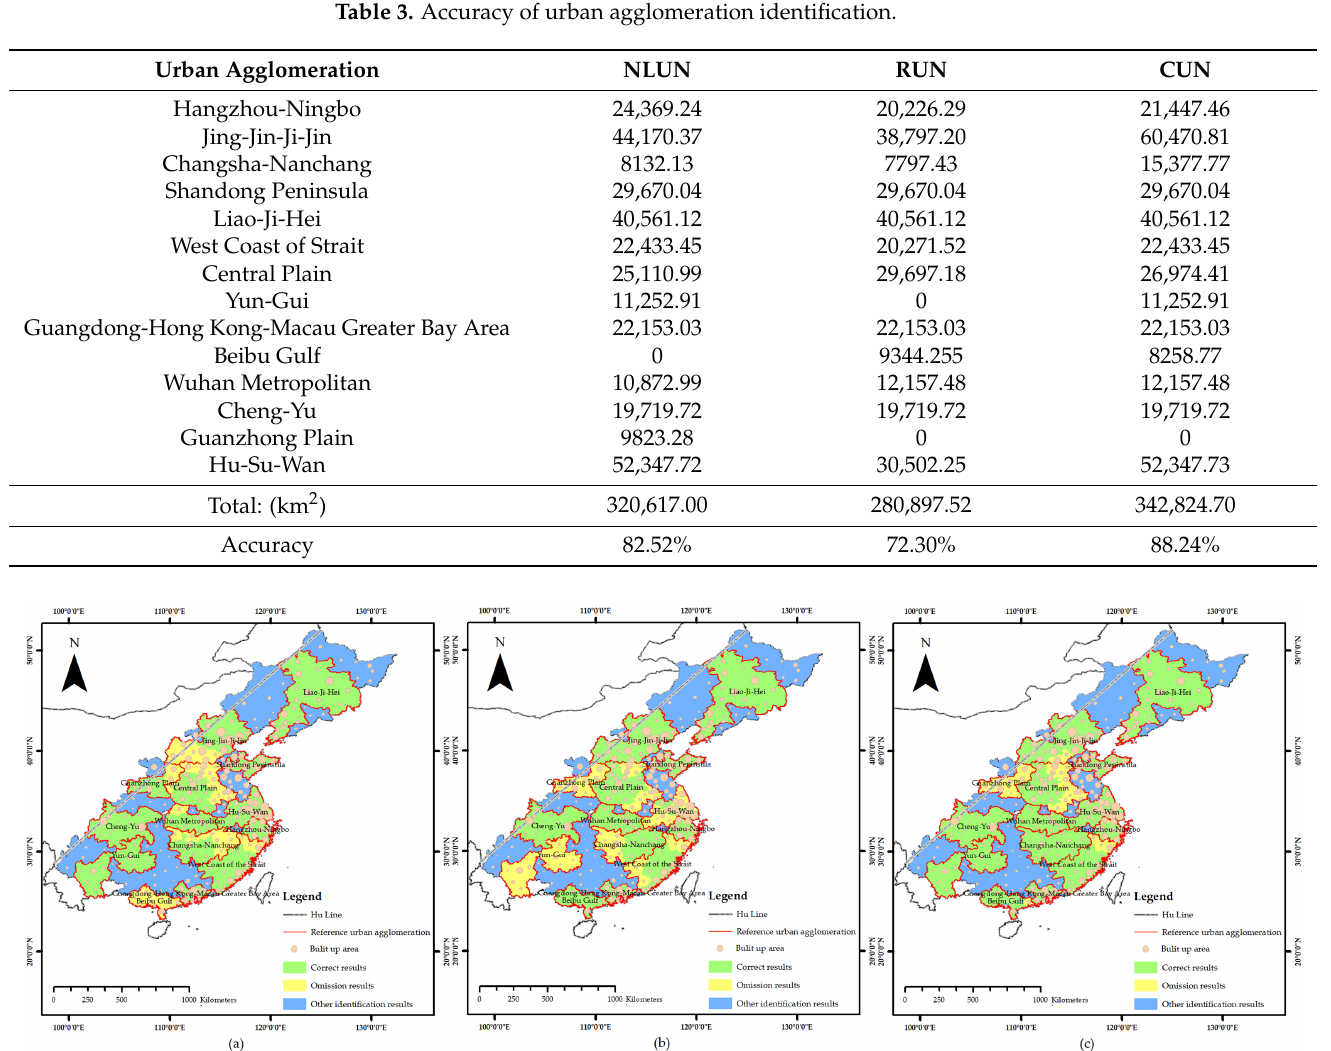
Figure 13. Comparison results of urban agglomeration extraction boundaries and reference urban agglomeration boundaries. ( a ) Nighttime light urban network; ( b ) Railway urban network; ( c ) Composite urban network.